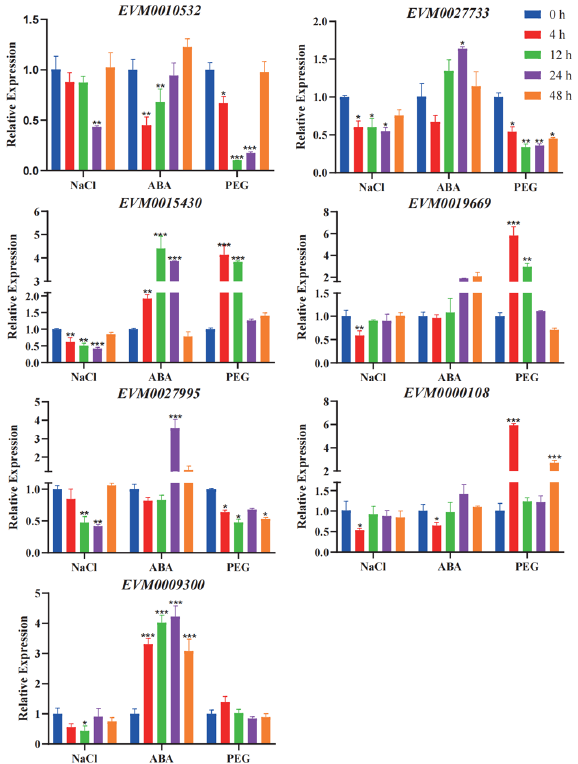
Figure 6. Relative expression levels of seven genes of WRKY, PHD, and MYB gene families verified by qRT ‐ PCR under NaCl, ABA, and PEG stress treatments. Different colors in the histogram indicate stress treatment time at different time periods from 0 to 48 h. The error bars indicate the means ± SD ( n = 3). Asterisks indicate a significant difference as determined by a Student’s t − test (* p < 0.05, ** p < 0.01, and *** p <